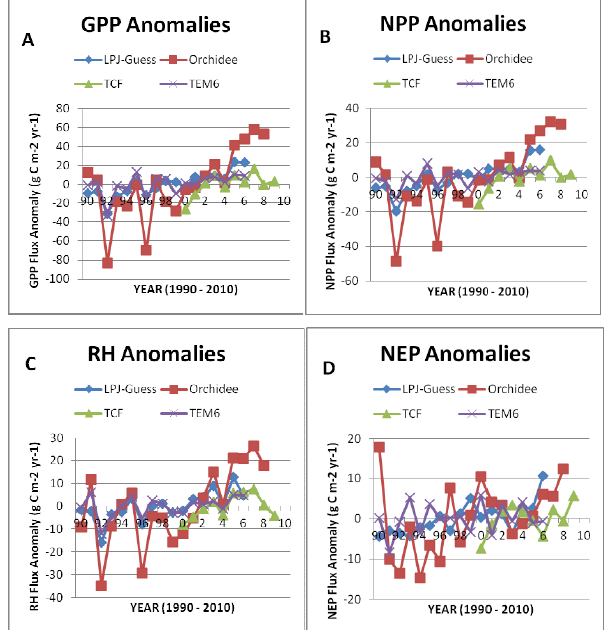
Fig. 5. Comparisons among LPJ-Guess WHyMe, Orchidee, TCF, and TEM of inter-annual variability between 1990 and 2010 for anomalies of gross primary production (GPP, Panel A ), net primary production (NPP, Panel B ), heterotrophic respiration (NPP, Panel C ), and net ecosystem production (NEP, Panel D ).